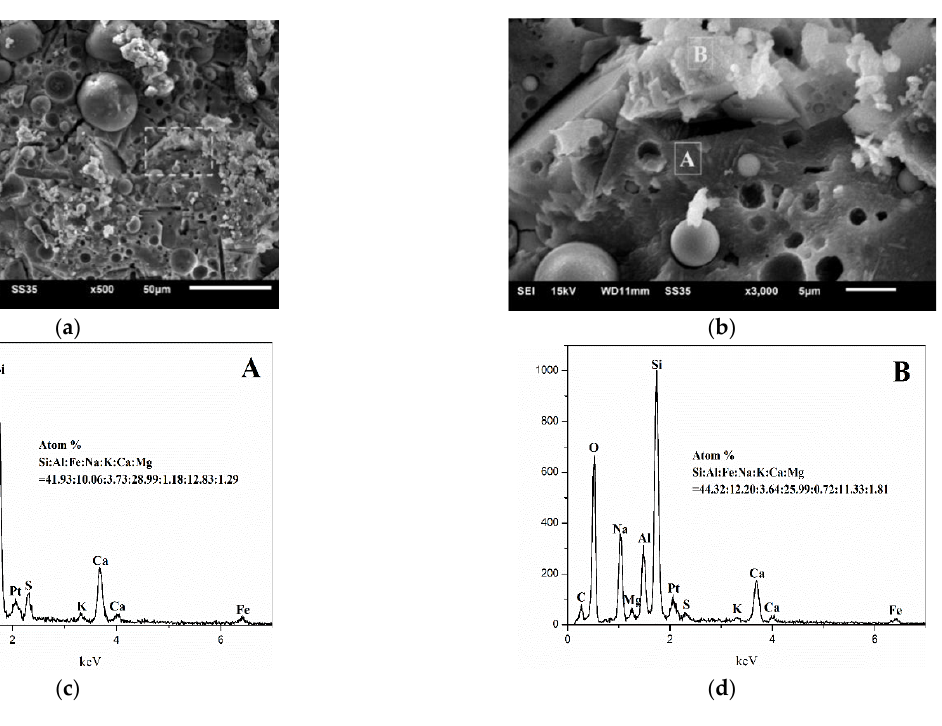
Figure 7. SEM–EDS patterns of G-9-12: ( a ) SEM image (×500); ( b ) SEM image (×3000); ( c ) elemental composition: Area A; ( d ) elemental composition: Area B.